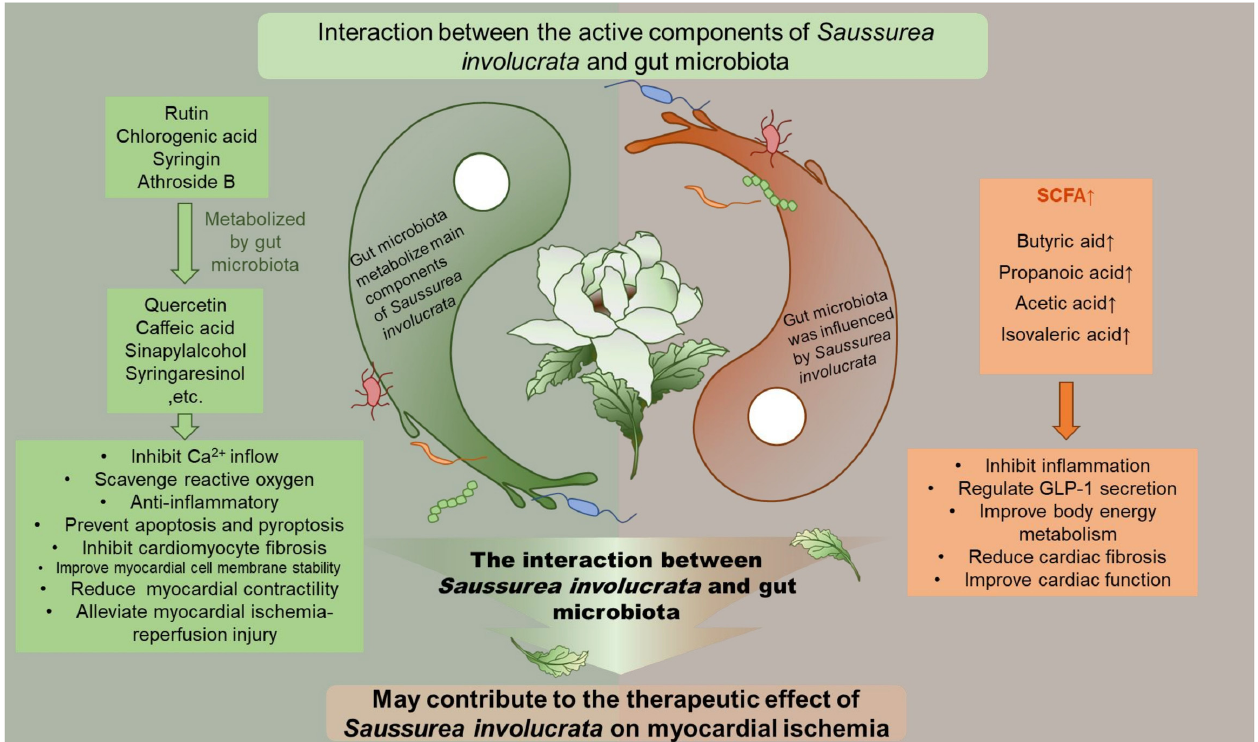
Figure 7. The gut microbiota interacts with the four main components of Saussurea involucrata (chlorogenic acid, syringin, acanthoside B, rutin). First, gut bacteria can metabolize the four main components of Saussurea involucrata (chlorogenic acid, syringin, acanthoside B, rutin) into the corre- sponding intestinal bacteria metabolites, which have potential therapeutic effects against myocardial ischemia; in addition, the four main components of Saussurea involucrata (chlorogenic acid, syringin, acanthoside B, rutin) can also in turn stimulate the production of short chain fatty acids (acetic acid, propionic acid, butyric acid, isovaleric acid) by intestinal bacteria, which further contributes to the protective effect of Saussurea involucrata against myocardial